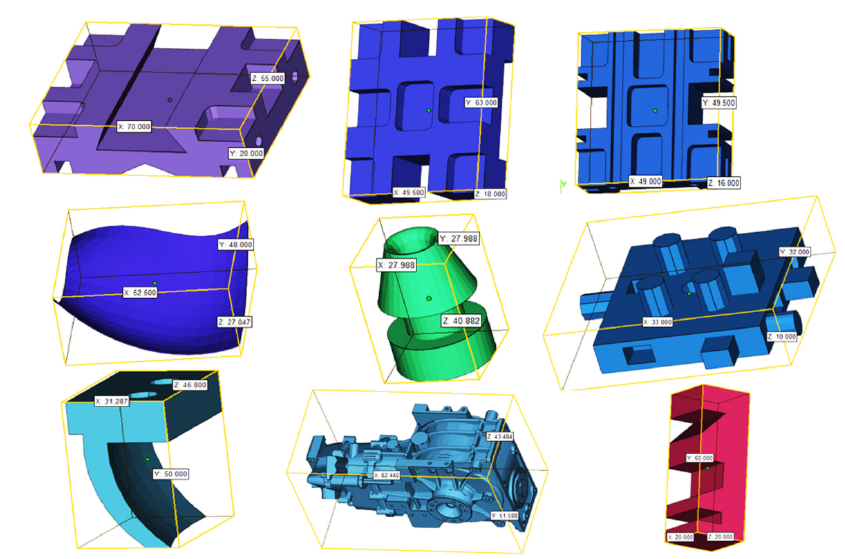
Figure 6. Components and their